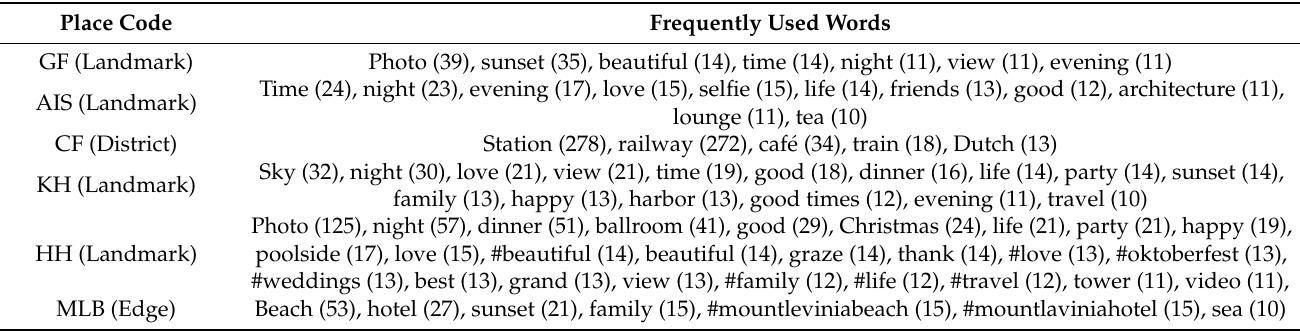
Table 4. Frequently used words attached to selected Lynchian